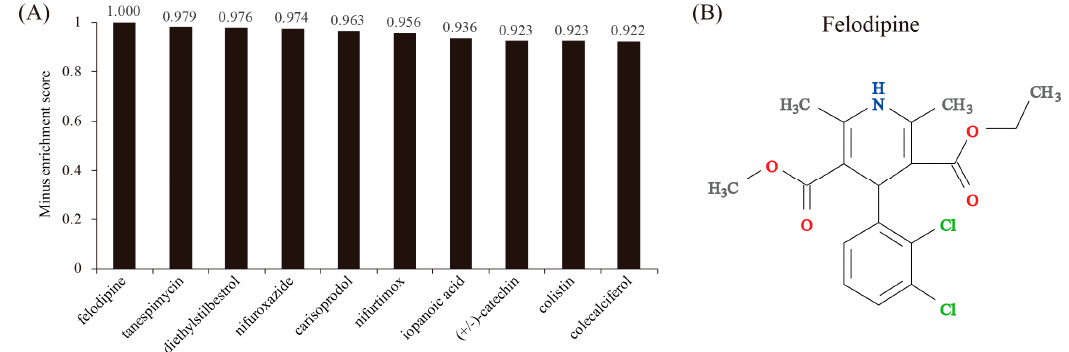
Figure 5. Connectivity map (CMap) analysis. ( A ) The enrichment scores of the top 10 chemical drugs resulting from CMap analysis. Differentially expressed genes were queried into CMap and chemical drugs showing a negative enrichment score were considered. ( B ) The molecular structure of the top- ranked chemical drug, felodipine.